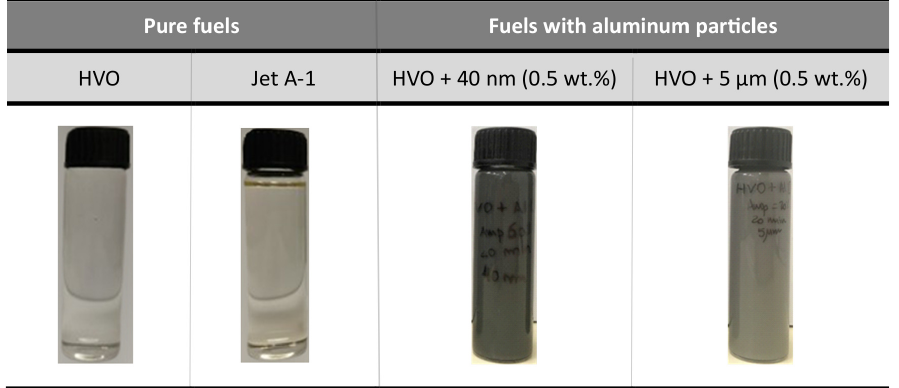
Figure 3. Fuels tested in the present work: HVO; Jet A-1; HVO + 40 nm (0.5 wt.%); and HVO + 5 µ m (0.5